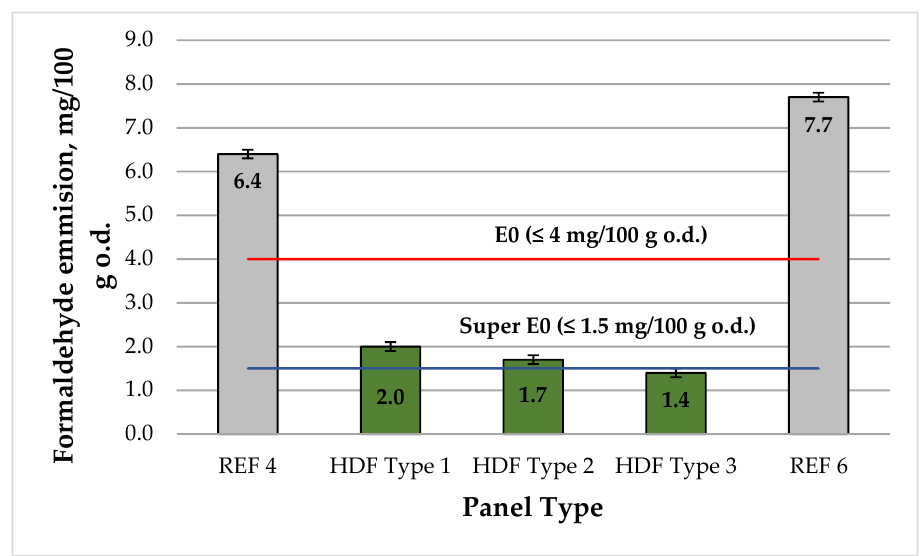
Figure 9. Free formaldehyde emission in the HDF panels produced: REF 4: 4% UF resin; HDF Type 1: 4% UF resin and 4% ALS; HDF Type 2: 4% UF resin and 6% ALS; HDF Type 3: 4% UF resin and 8% ALS; and REF 6: 6% UF resin. (Error bar represents the standard deviation, the red line represents the emission class E0 requirement, and the blue line represents the requirement of the emission class super E0.).